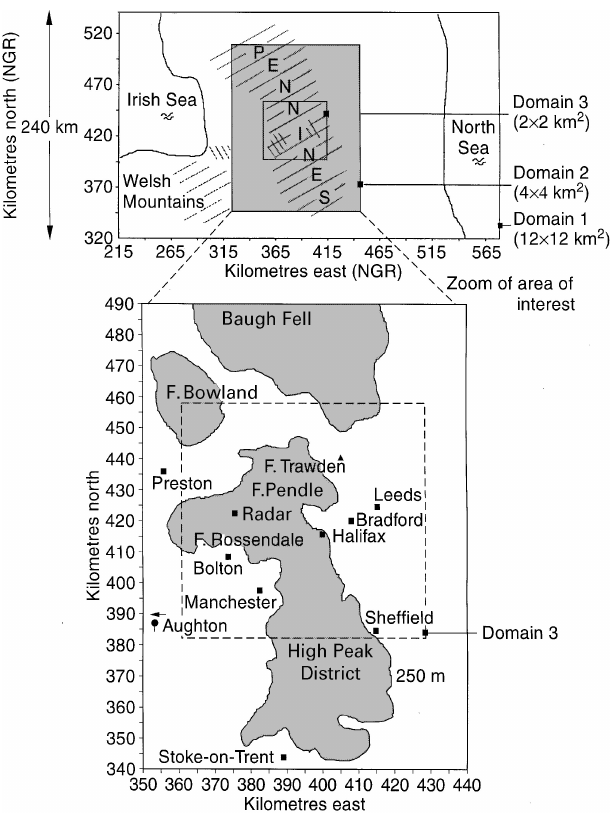
Fig. 1. Two schematic maps of the study area and model domains. The axes use standard national UK grid